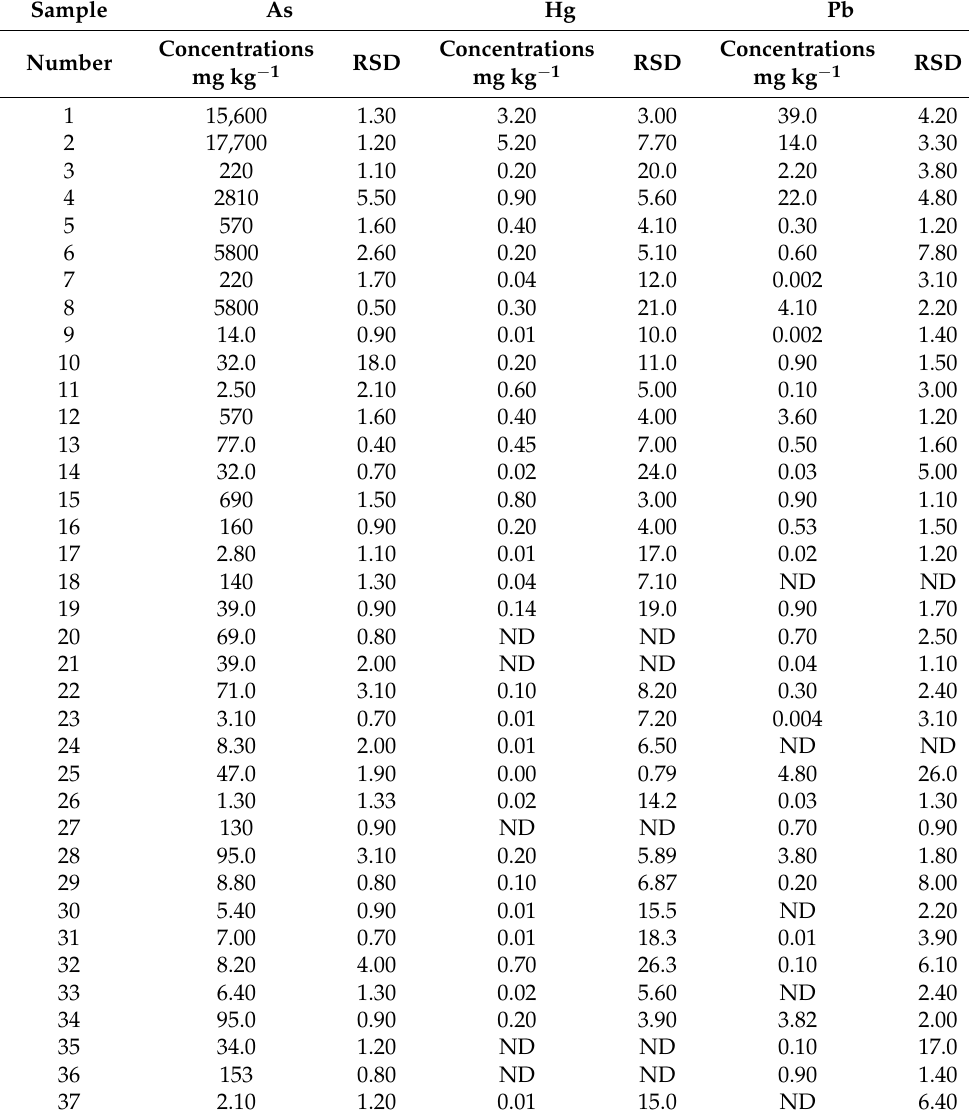
Table 3. Concentrations of As, Hg, and Pb in the P. vittata samples taken from the Bone River